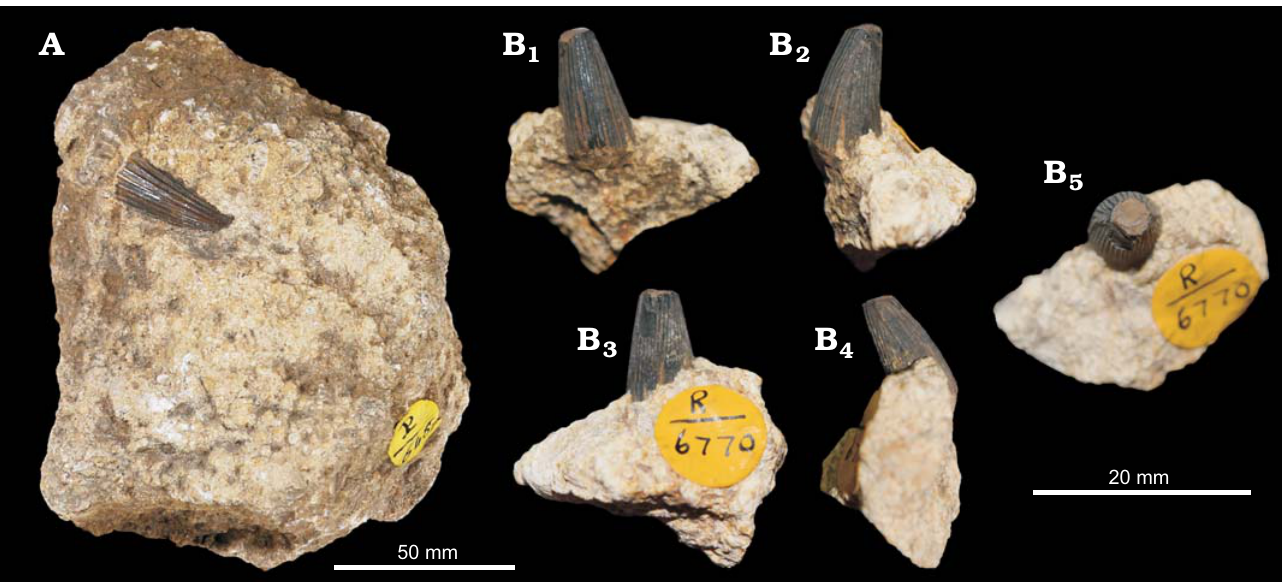
Fig. 7. Ichthyosaurid reptile cf. Ophthalmosaurus sp. (A) and Reptilia indet. (B) from Malton (Yorkshire), Oxfordian. A . NHMUK R 648, isolated crown, the exact view cannot be assessed. B . NHMUK PV R 6770, tooth in labial (B 1 ), axial (B 2 , B 4 ), lingual (B 3 ), and apical (B 5 )